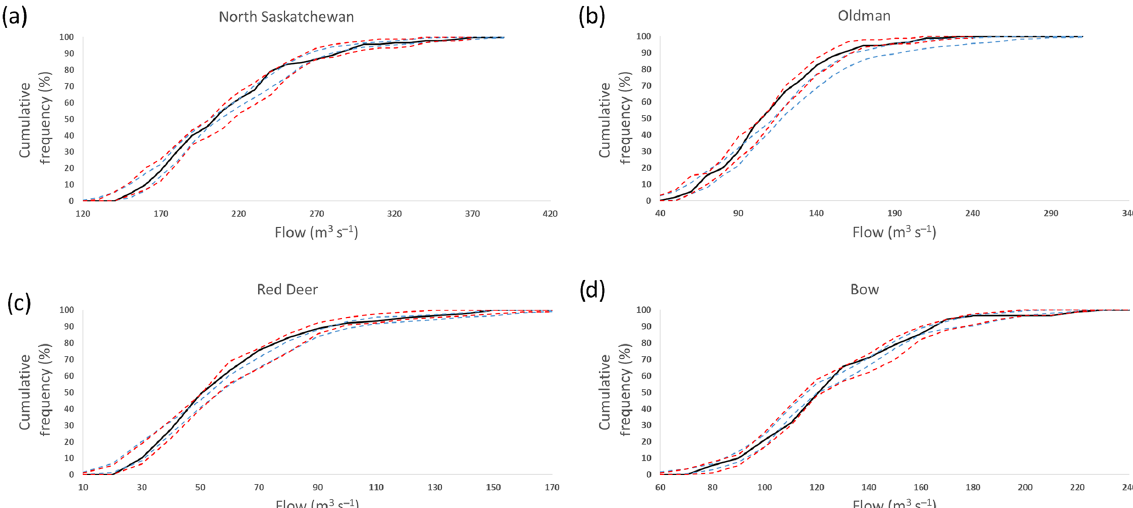
Figure 6. Cumulative frequency distributions (CFDs) between reconstructed flow and reference naturalized flow at a yearly time step. The minimum and maximum bounds of the CFDs of the 30 reconstructed flows for the reference and full period are represented by the dotted red and dotted blue lines, respectively, whereas the CFD for the reference flow is indicated by the solid black line: (a) North Saskatchewan River, (b) Oldman River, (c) Red Deer River (d) Bow